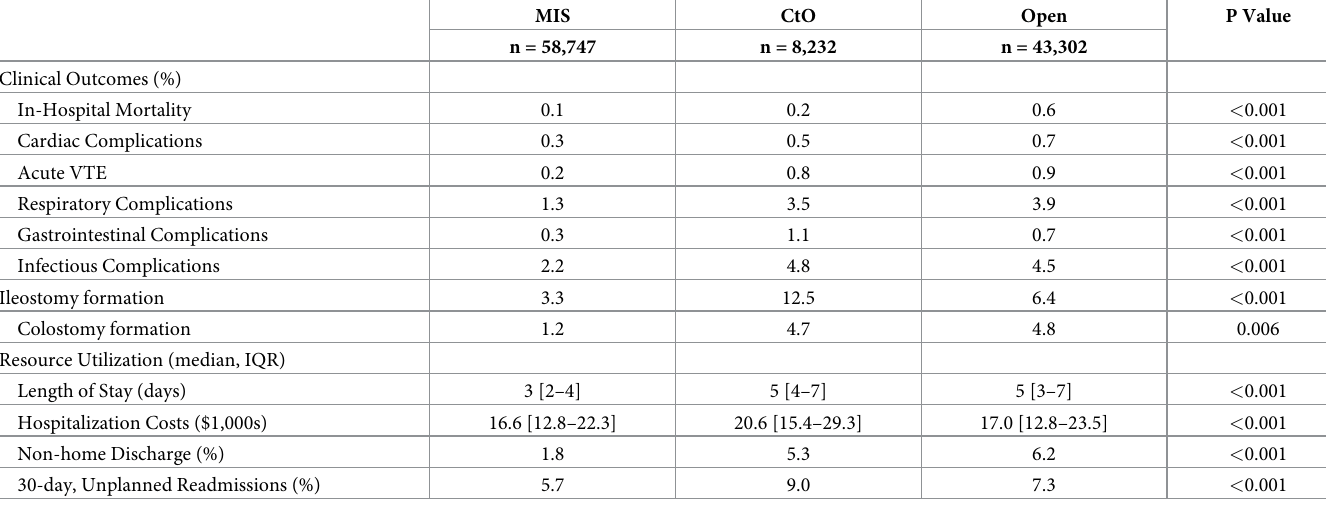
Table 2. Crude outcomes for patients with diverticulitis undergoing elective colectomy stratified by operative approach. MIS CtO Open P Value n = 58,747 n = 8,232 n =